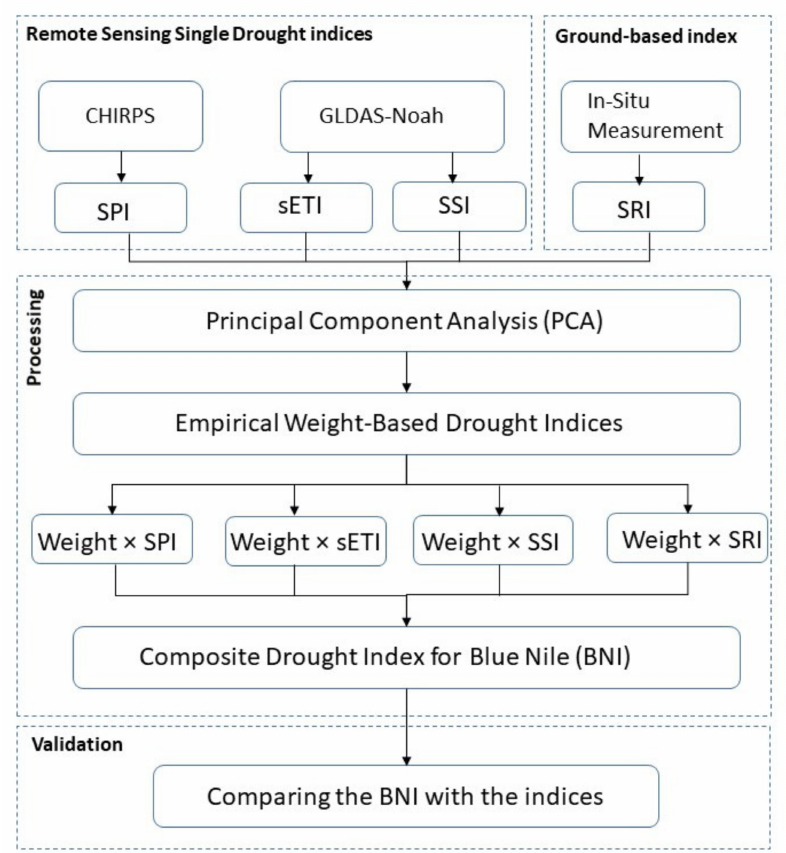
Figure 6. Methodology flowchart for creating the composite drought